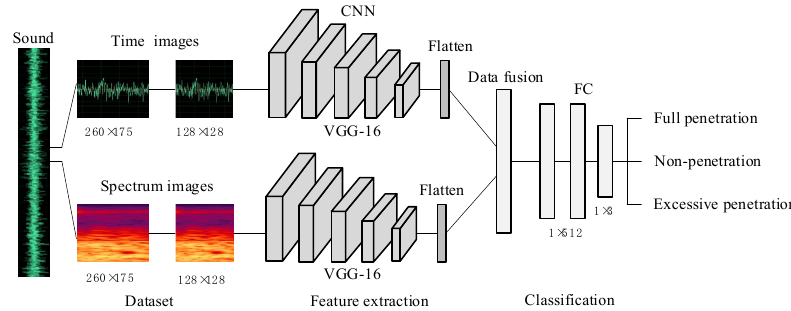
Figure 1. Dual-input model for weld penetration classification.